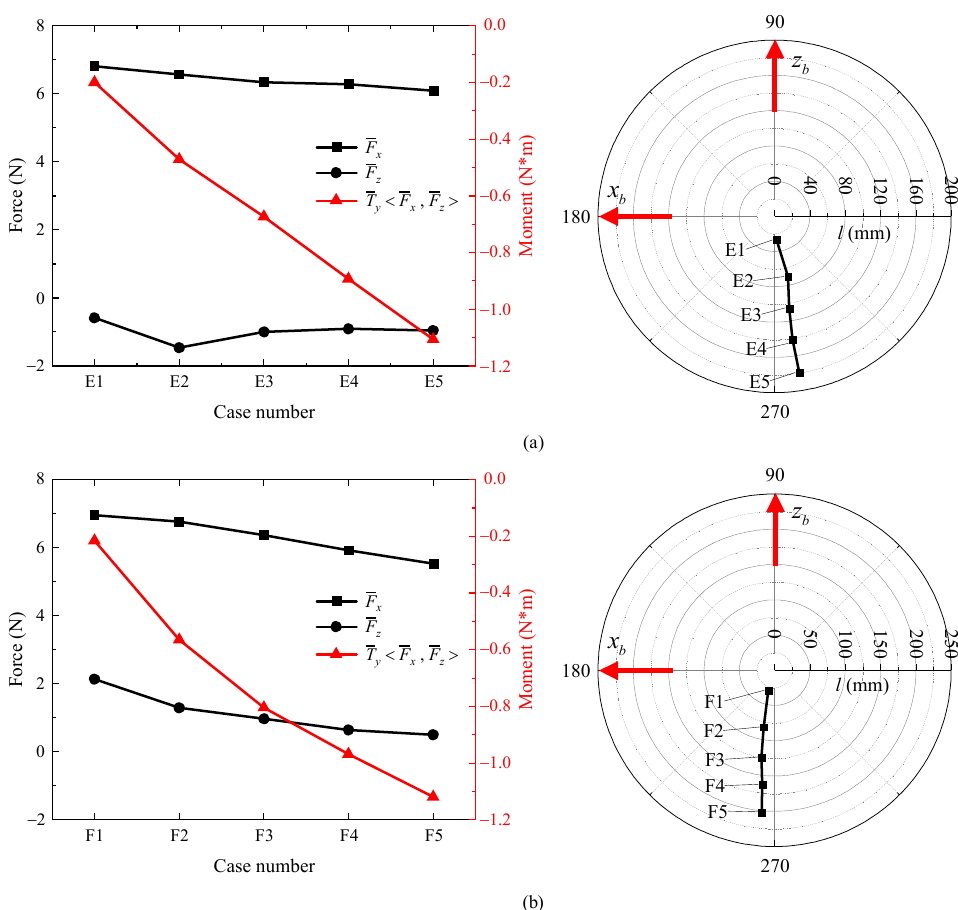
Figure 14. Hydrodynamic performance and equivalent point variation in pitching torque. ( a ) Experimental results of Case E. ( b ) Experimental results of Case F.